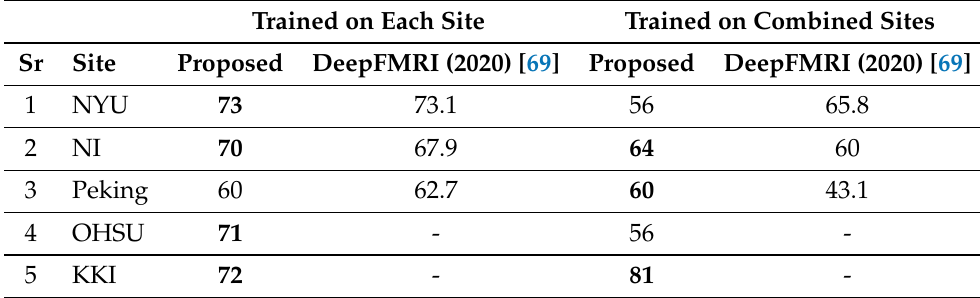
Table 5. Accuracy(%) comparison of trained model using combined and individual sites. Trained on Each